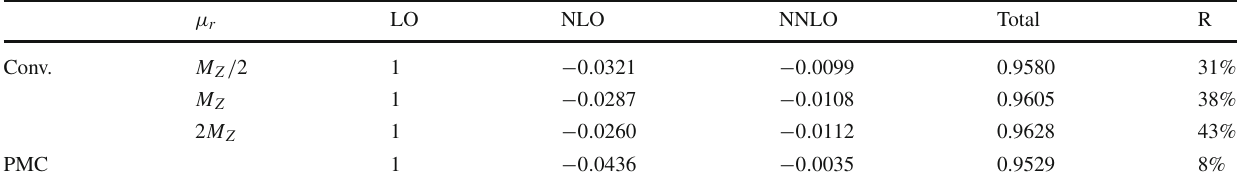
Table 1 The QCD correction factors A FB / A LO forward–backward asymmetry with the thrust axis definition at LO, NLO, NNLO using the conventional (Conv.) and PMC scale